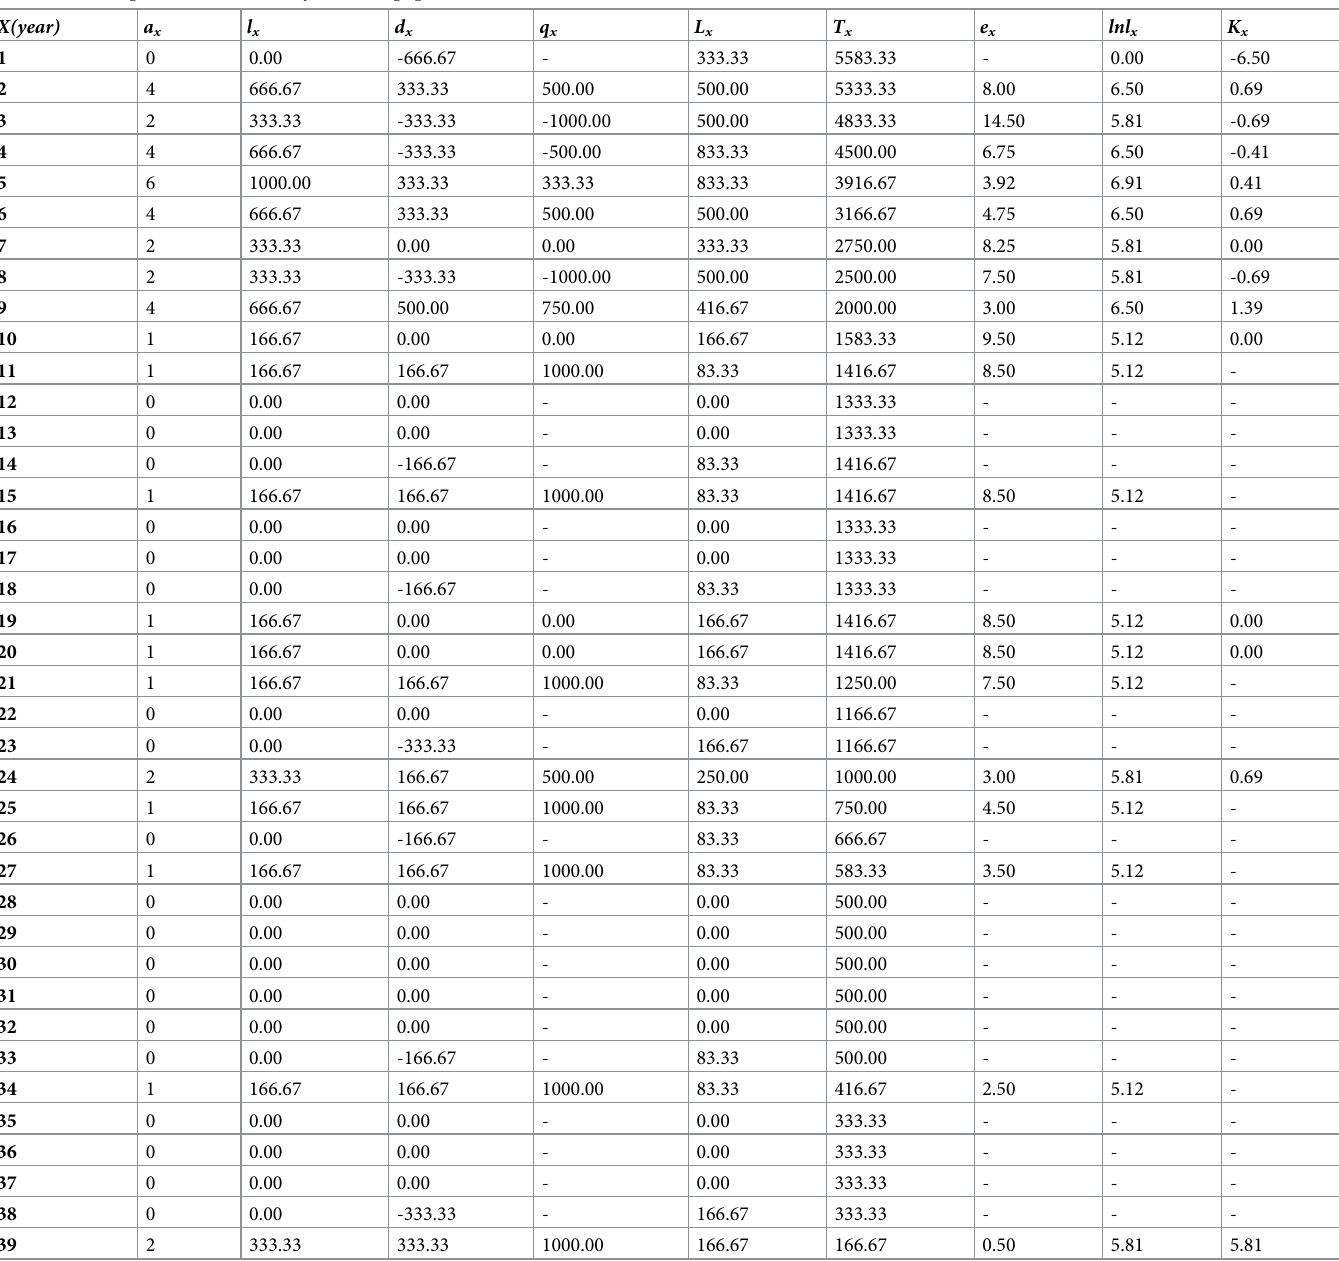
Table 4. Time-specific life table of P . flavus BM